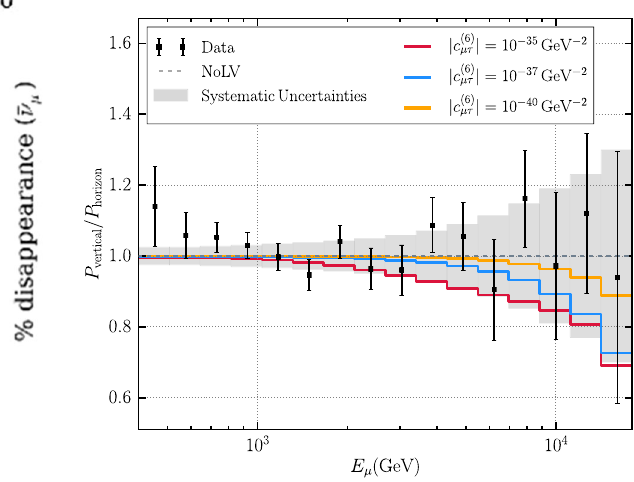
panelshowstheratioofthemuon-neutrinosurvivalprobabilitybetween a scenario with Lorentz violation and the standard case as a function of the neutrino energy. Different color lines indicate different values of the dimensionful coupling of the effective operator that governs the neutrino interaction with the Lorentz violating field. Figure is taken from